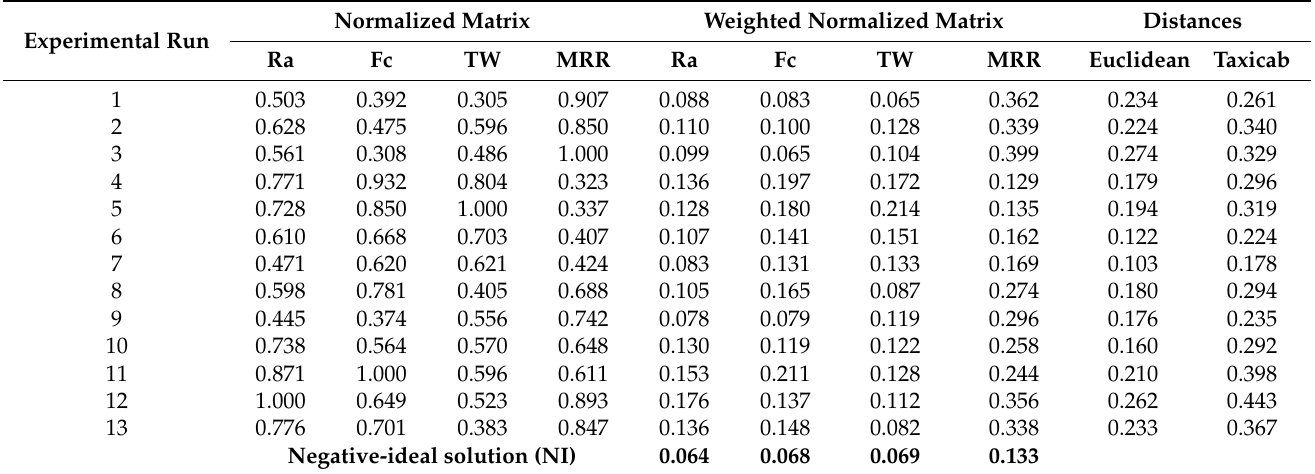
Table 9. Normalized and distance values of responses.